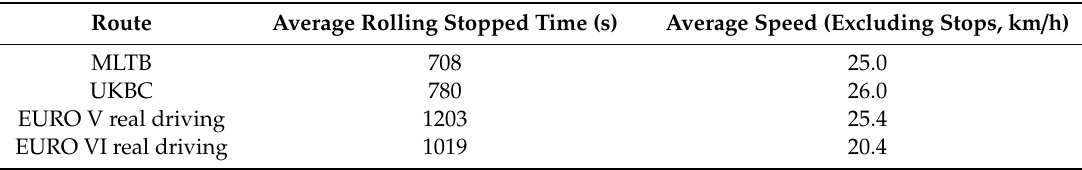
Table 3. Average rolling stop time and average speed of the routes.